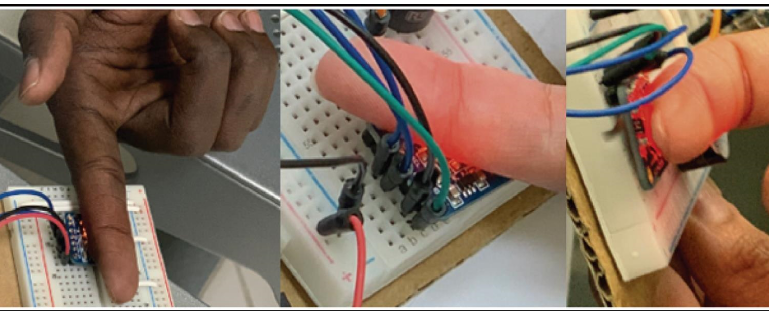
Figure 1: Measuring diferent skin types using the color sensor, where these measurements were used to build the database that used to classify skin types.